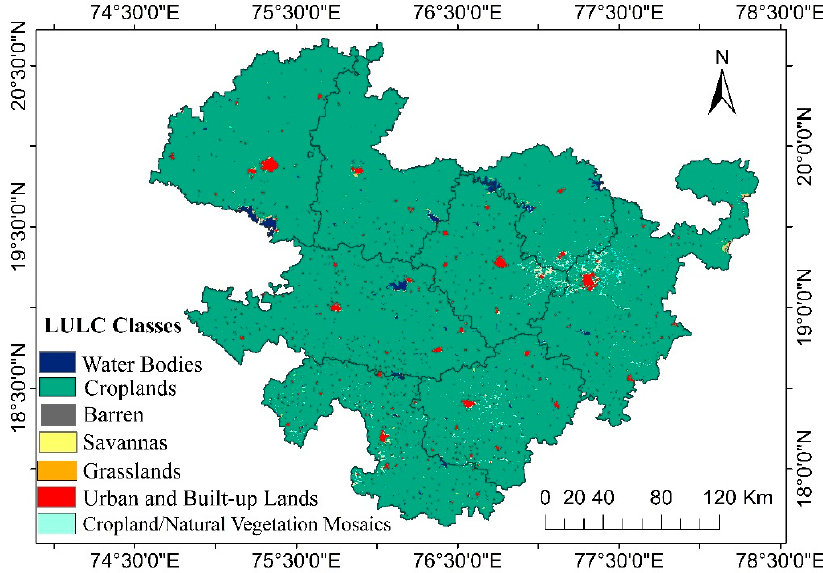
Figure 3. Sample land use land cover map (the year 2002) derived from Moderate Resolution Imaging Spectroradiometer (MODIS). Table 2. Land Use Land Cover (LULC) classes and percentage-wise area under each category based on MODIS data (2017).